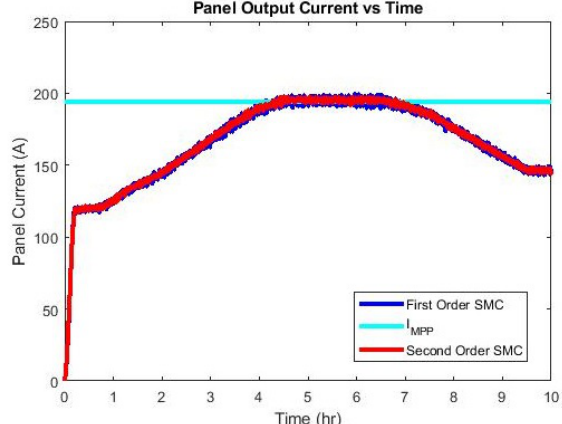
Figure 16. PV array output current under changing irradiation.